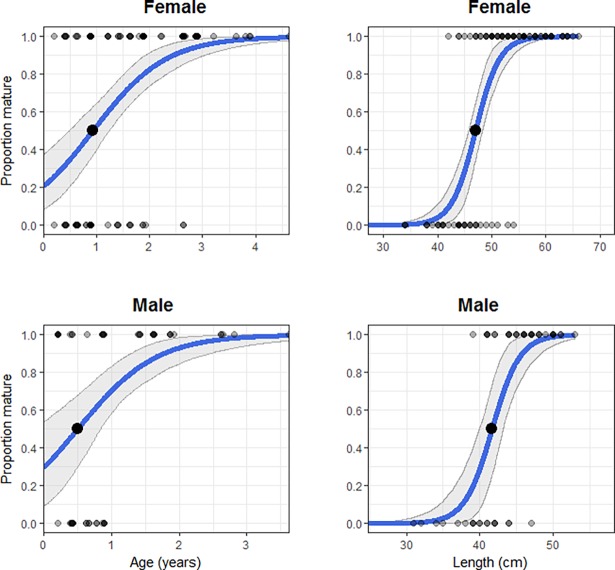
Age and length-at-maturity ogives for female and male Rhizoporionodon taylori from the Gulf of Papua.The large points on the curve represent the length and age at which 50% of population reaches maturity. 95% bootstrapped confidence intervals are indicated with shaded areas.